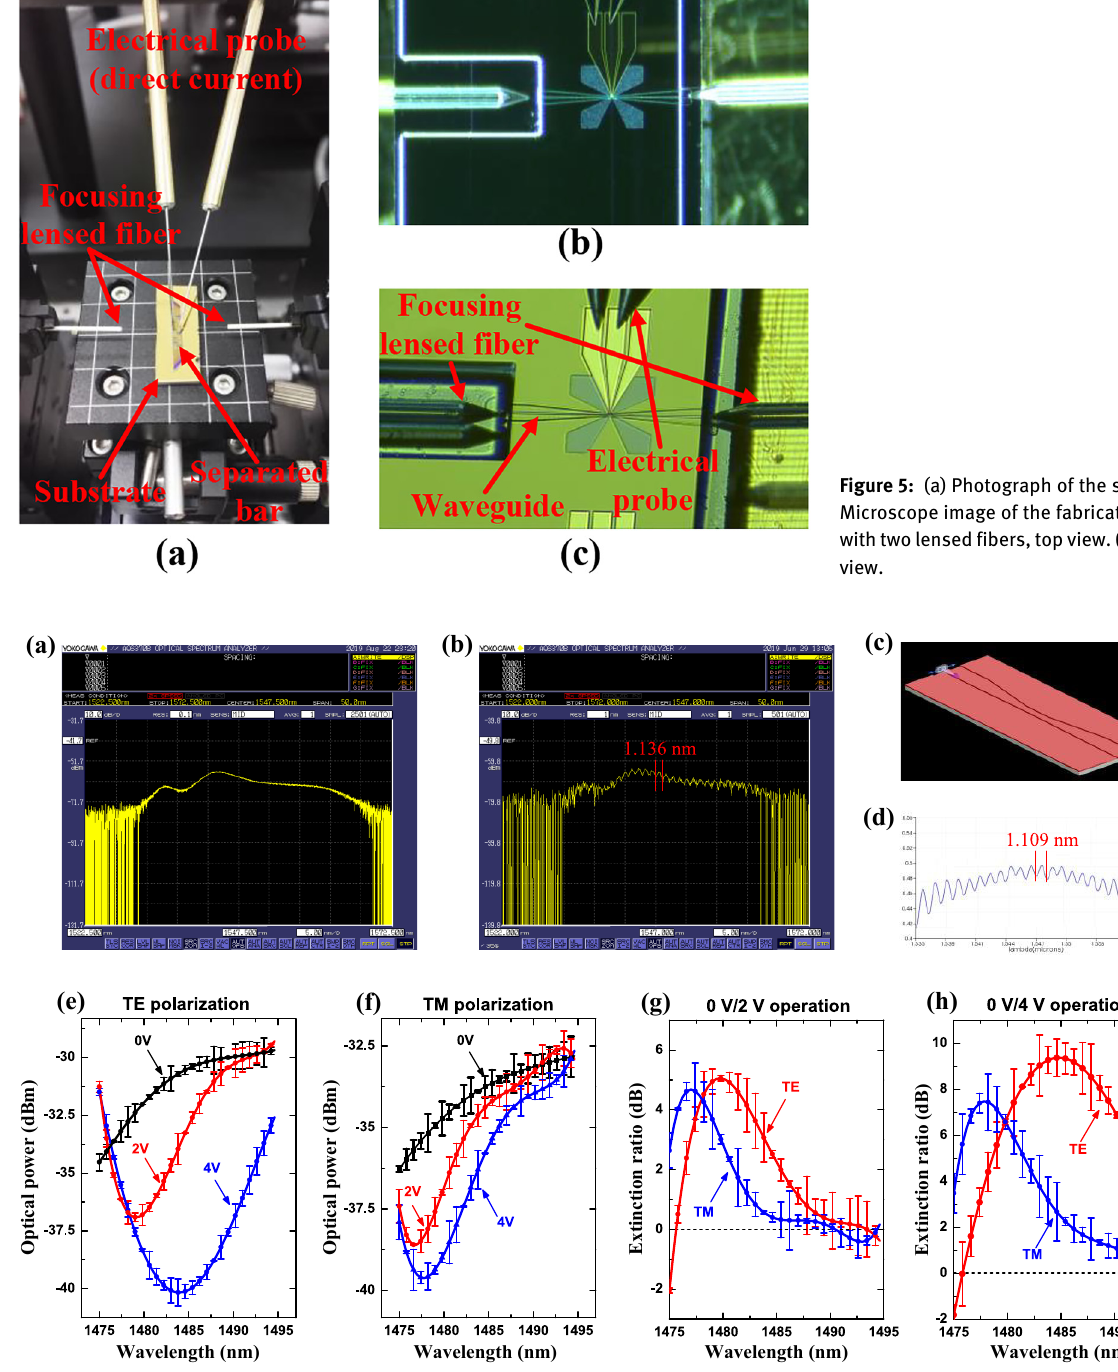
Figure 6: (a) Transmission spectrum when the focusing lensed fiber is aligned to the Si substrate, (b) transmission spectrum when the focusinglensed fi beris alignedto thedevicewaveguide, (c) fi nite-differencetime-domain(FDTD)simulationmodel,(d)FDTDsimulationresult of the transmission spectrum around 1547 nm wavelength. (e) The transmitted light power under TE polarization, (f) the transmitted light power under TM polarization. (g) Extinction ratios under 0 V/2 V operation, (h) extinction ratios under 0 V/4 V